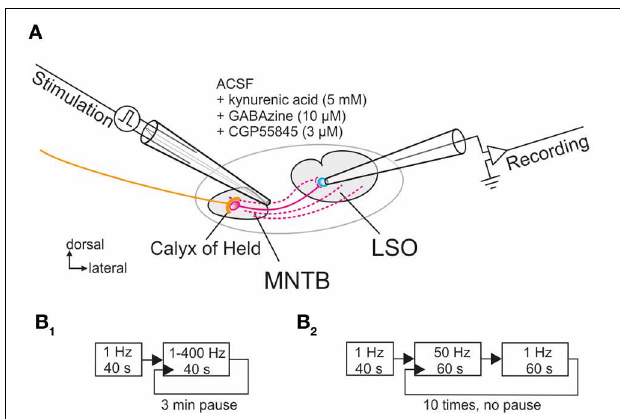
FIGURE 1 | Whole-cell patch clamp recordings from LSO neurons located in the central region of the nucleus upon electrical stimulation of their input fibers from the MNTB. (A) Schematic view of the circuit as seen in a coronal brainstem slice. A theta glass electrode was used for focal electrical stimulation and placed at the lateral border of the MNTB to reach the maximum number of connecting fibers (depicted in magenta). Glycinergic transmission was pharmacologically isolated with the depicted drugs. (B 1 , B 2 ) Scheme of the two protocols used for prolonged and very prolonged stimulation, comprising up to 30,600